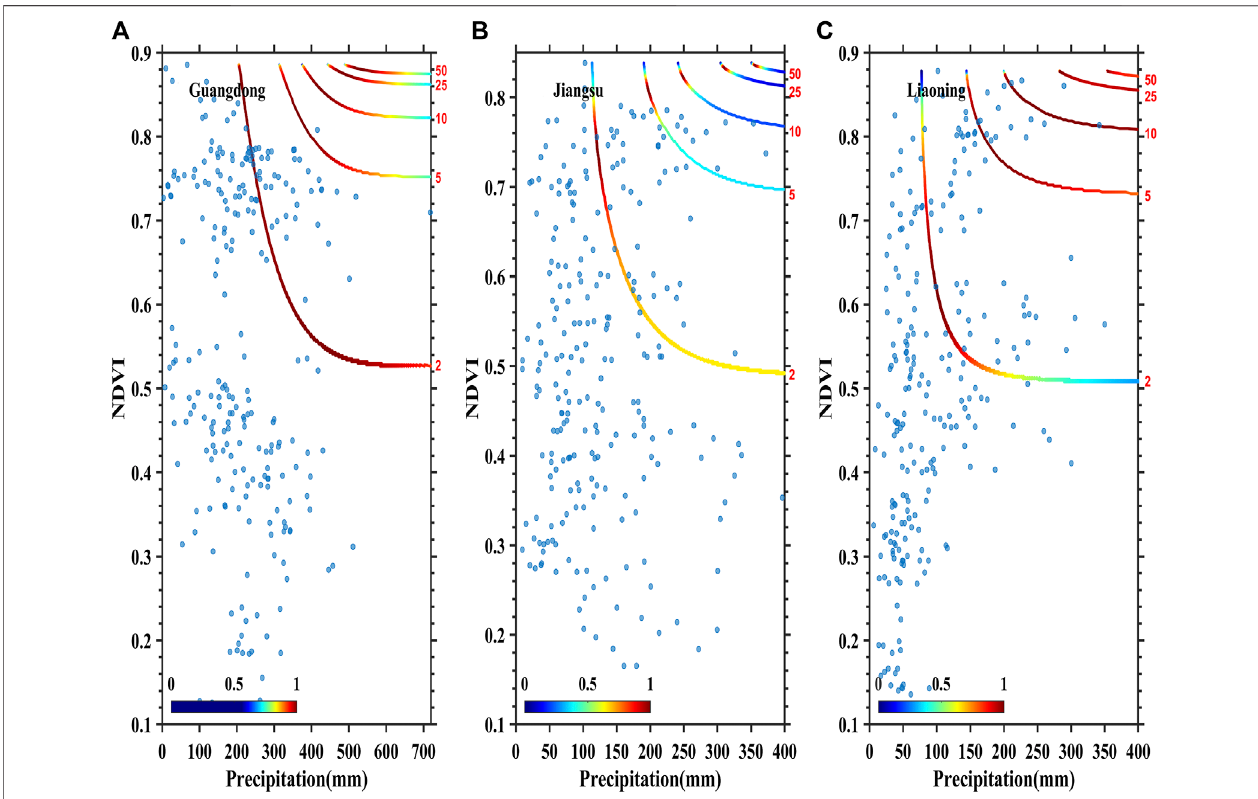
FIGURE 9 | Joint copula return periods of precipitation-normalized difference vegetation index (NDVI) in (A) Guangdong, (B) Jiangsu, and (C) Liaoning.